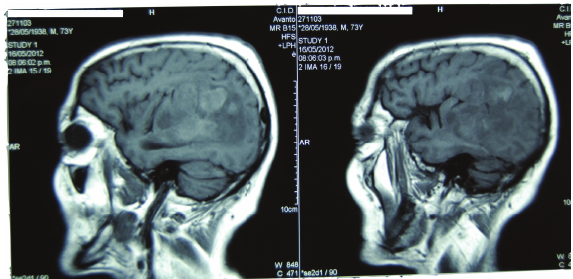
Figure 1: An extensive left frontal-temporal-parietal lesion is ob-